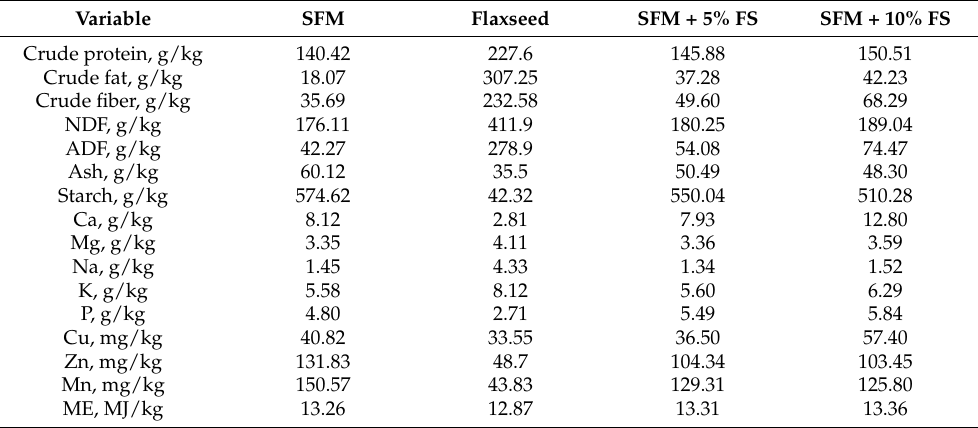
Table 2. Nutritional composition of standard feed, flaxseed and combination calculated to 100% of dry